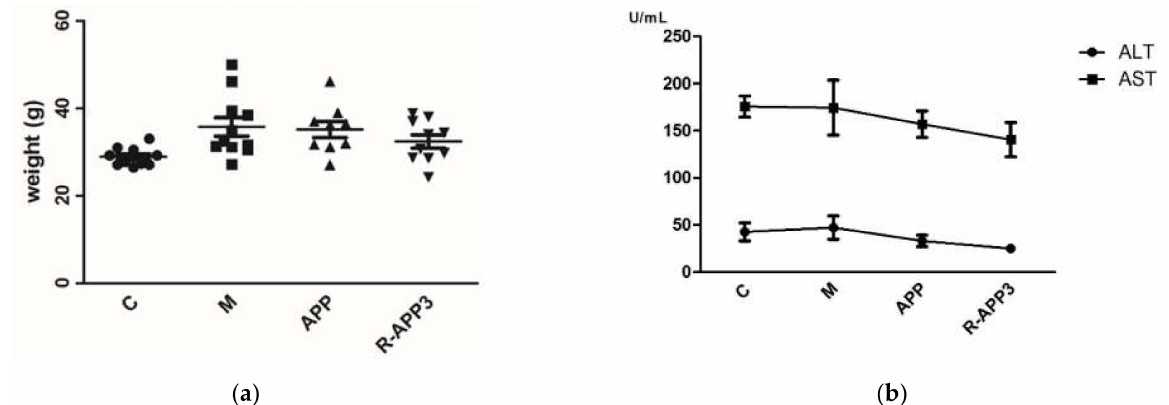
Figure 6. The body weight and serum aminotransferase of normal mice and hypercholesteremic mice. C, normal mice; M, hypercholesteremic mice by intragastric administration of distilled water; APP and R-APP3, hypercholesteremic mice by the intragastric administration of native APP and irradiated APP at a dose of 1000 kGy. ( a ) Body weight of mice, dots with different shapes represented the mice from different groups. ( b ) Serum aminotransferase of mice. Table 2. Serum and hepatic lipid profiles in mice.